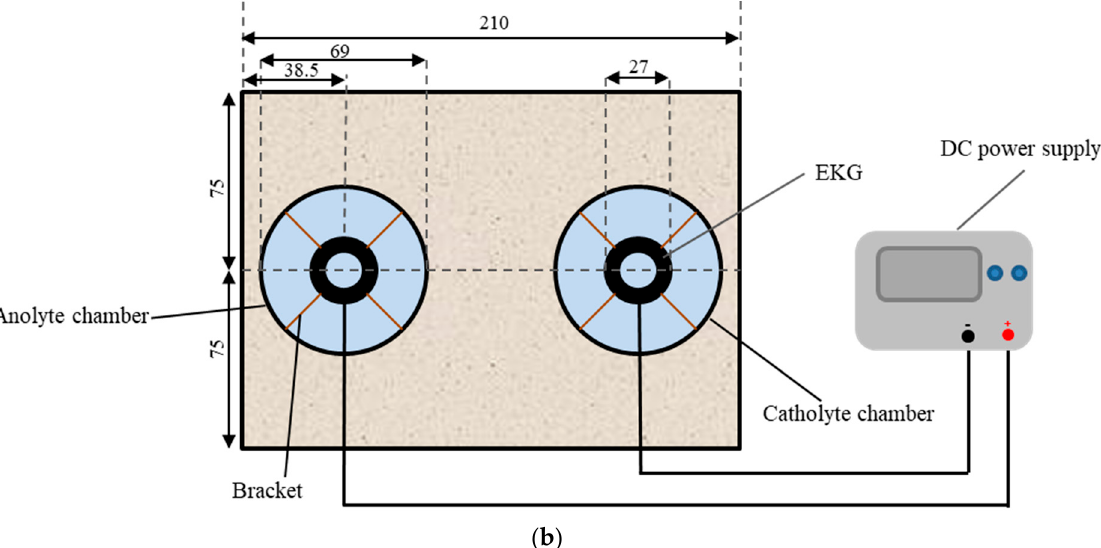
Figure 1. Schematic diagram of the novel electrolyte chamber configuration for electrokinetic remediation: ( a ) front view and ( b ) top view (unit mm).